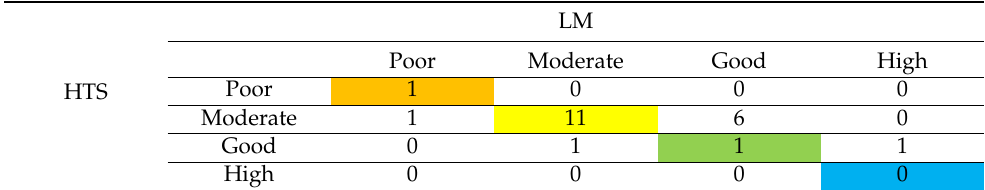
Table 3. Comparison between trophic status classes of morphological (LM) and molecular-based (HTS) inventories.